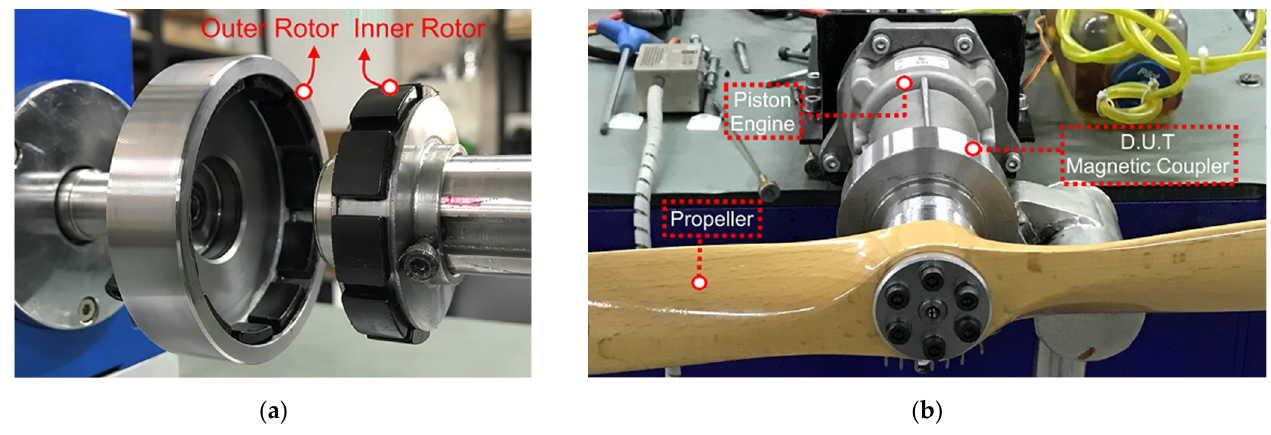
Figure 22. Assembly of ( a ) MC for dynamic tests; ( b ) MC with piston engine and propeller.